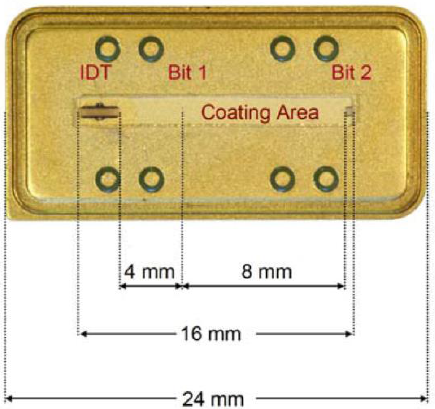
Figure 10. A typical RFID-tag coated with polyvinyl alcohol for humidity sensing. The figure shows the design details of the device, including the dimensions of the IDT, coating area and distances between IDT, Bit 1 and Bit 2 (reflections). Reproduced from [160], copyright Molecular Diversity Preservation International (MDPI).